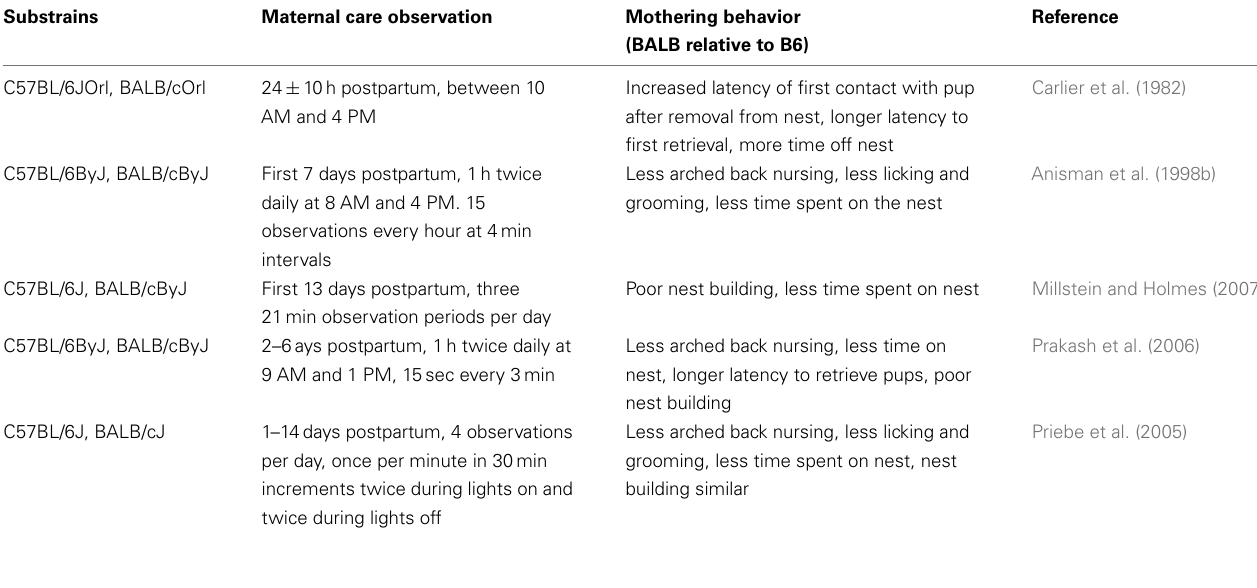
Table 1 | Maternal care differences in B6 and BALB